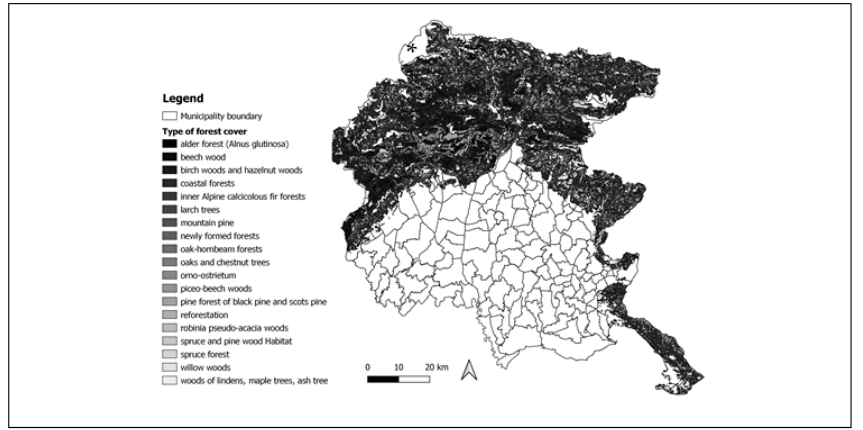
Figure 2. Source: SITFOR FVG. Geographic distribution of forest categories. Regional Infrastructure of Environmental and Territorial Data (IRDAT). * Municipality of Sappada: data unavailable.